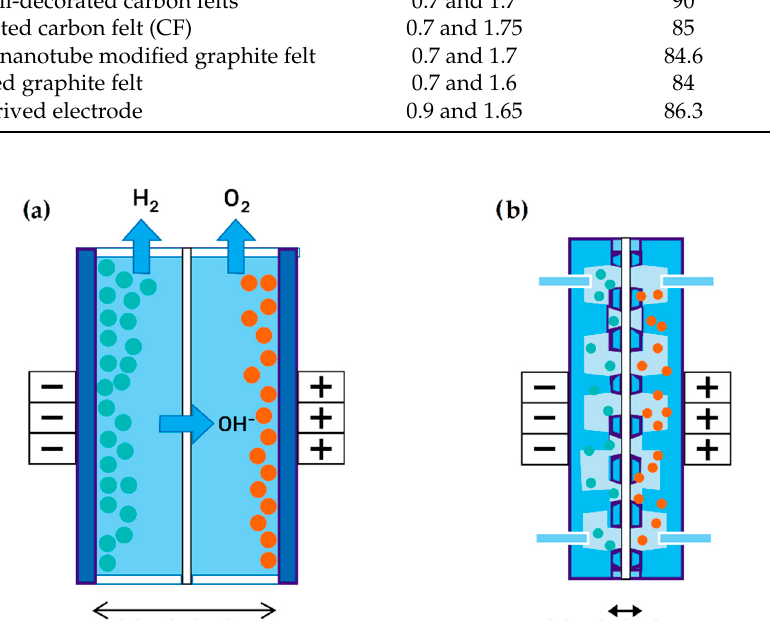
Figure 5. Electrode configuration: ( a ) Traditional setup; ( b ) zero-gap design of porous electrodes.